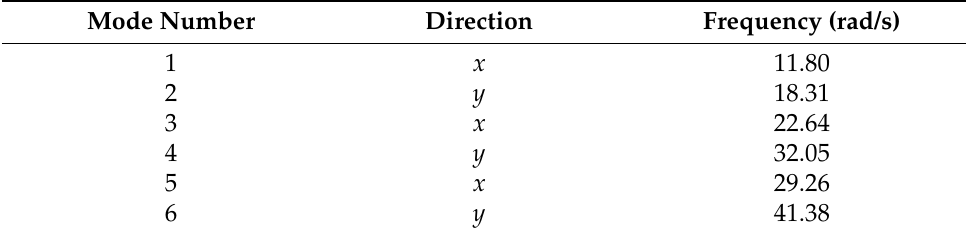
Table 4. Linear sloshing natural frequencies—Case study